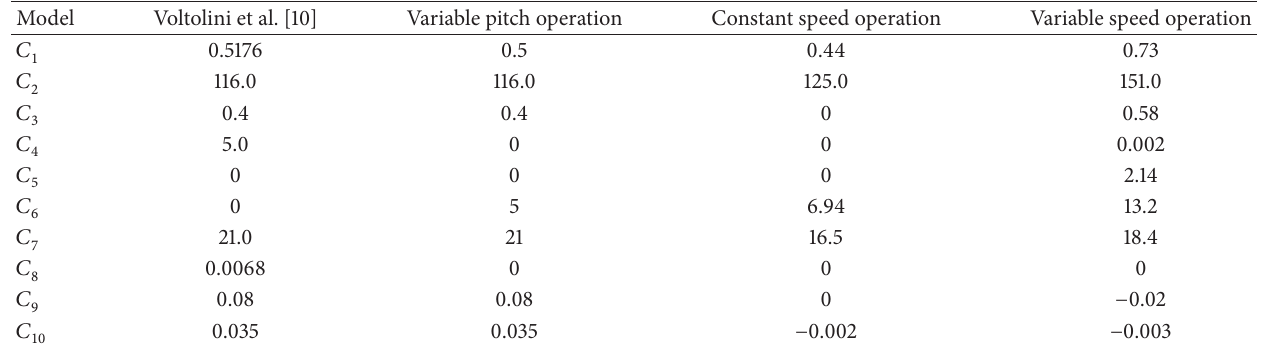
Table 1: Coefficients 𝐶 𝑖 , 𝑖 = 1, 2,3, . .. ,10 , of the approximations to the power coefficient 𝐶 𝑝 (𝜆,𝜃) .